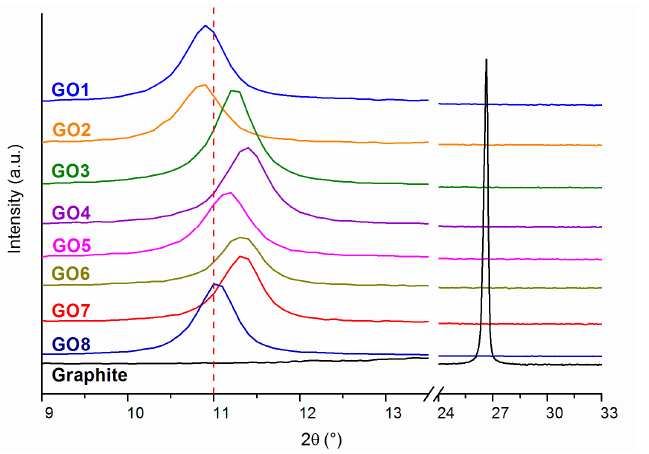
Figure 3. WAXS patterns for graphite and for graphene oxides obtained using various methods.